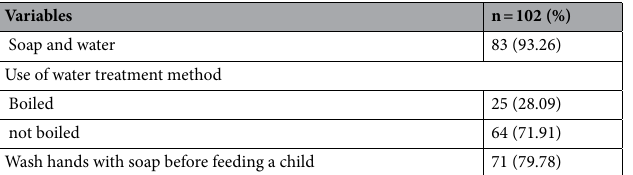
Table 1. Baseline socio-demographic, anthropometric, clinical characteristics, and laboratory findings of the enrolled male children (6–36 months) (n = 102). *mean ± SD (standard deviation); TCO 2 : total carbon dioxide; Stunting: height/length for age z score < -2; Wasting: weight for height z score < -2; Underweight: weight for age z score < -2; EAEC: Enteroaggresive E. coli; EPEC: Enteropathogenic E. coli ; ETEC: Enterotoxigenic E. coli.